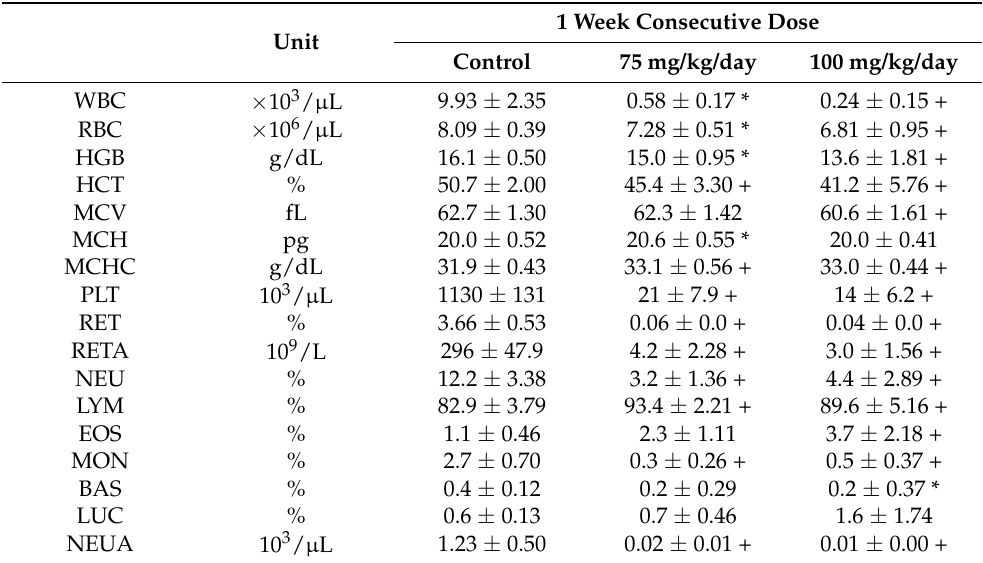
Table 3. Hematological parameters obtained on 1-week consecutive ifosfamide-administered